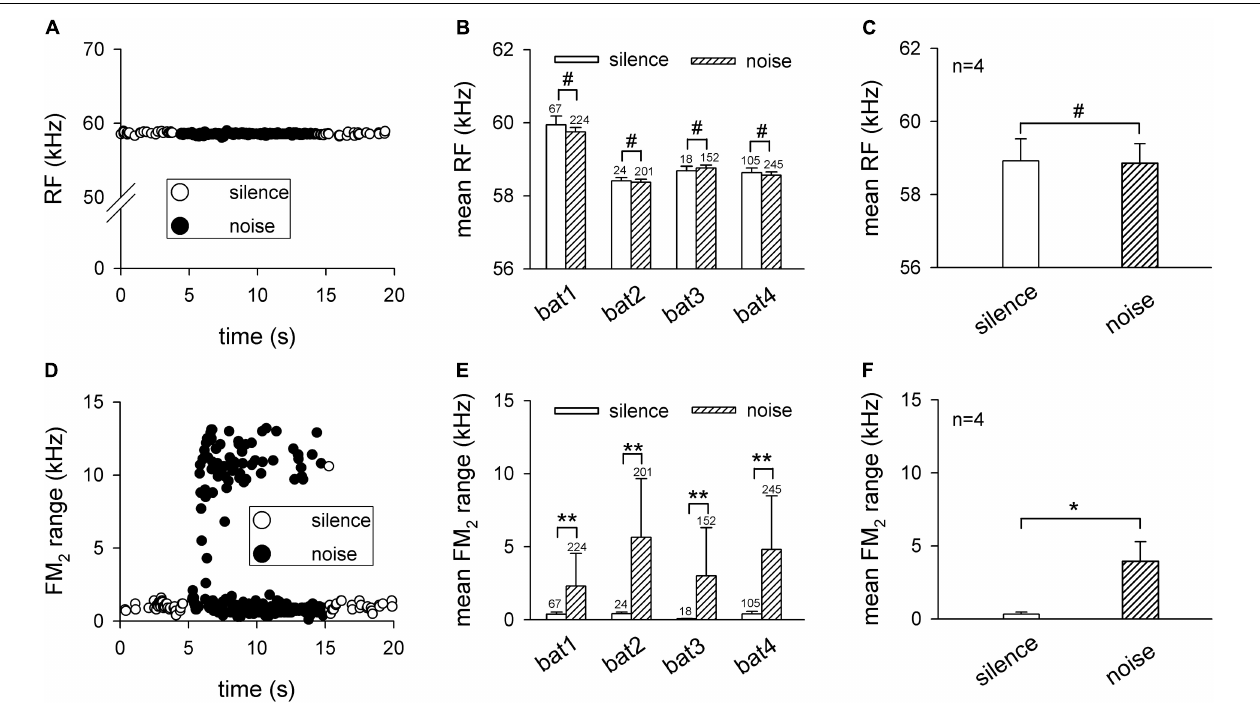
FIGURE 2 | The noise influence on the second harmonic of the echolocation call of Hipposideros pratti in the frequency domain. (A) The RF of a representative echolocation call trial from a bat before (0–5 s), during (5–15 s), and after (15–20 s) exposure to background white noise, showing a nearly constant RFs during the background noise. (B) Comparison of the each bat’s RF in silence and noise conditions. Although the RF of each bat varied a small amount, all bats kept the RF unchanged in the noise condition. (C) Comparison of the mean RF for all bats between silence and noise conditions, showing that H. pratti kept the RF unchanged in silence and noise conditions. (D) The FM 2 range of a representative echolocation call trial from a bat before (0–5 s), during (5–15 s), and after (15–20 s) background white noise, showing that the FM 2 range of some calls increased during the background noise. (E) Comparison of each bat’s FM 2 range in silence and noise conditions, showing that all bats significantly increased the FM 2 range in the noise condition. (F) Comparison of the mean FM 2 range for all bats between silence and noise conditions, showing that H. pratti significantly increased the FM 2 range in noise conditions. RF, resting frequency. FM 2 , frequency modulation of the H2. # p > 0.05; * p < 0.05; ** p <